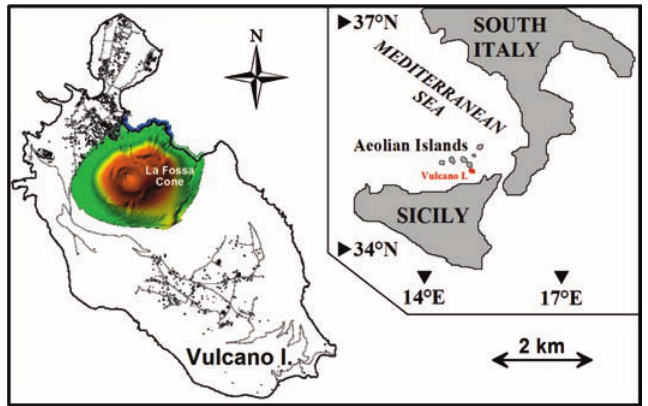
Figure 1. Location of Vulcano Island and the La Fossa cone.